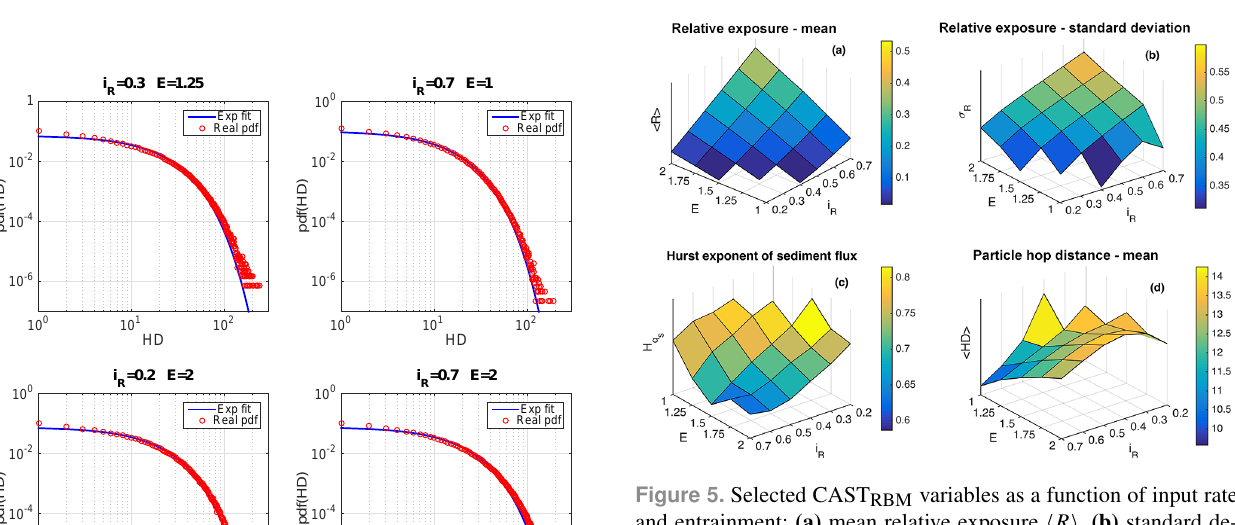
Figure 4. Probability density functions of simulated particles hop distances (red dots) fitted with an exponential distribution (blue line) for four different parameter sets.